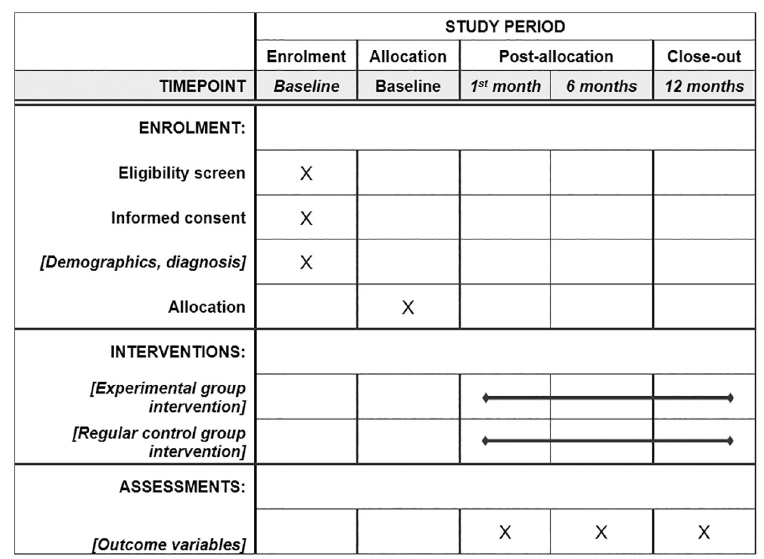
Fig 1. SPIRIT 2013 schedule. SPIRIT schedule of enrollment, interventions and assessments timepoints along the study period (1 year maximum after the allocation).